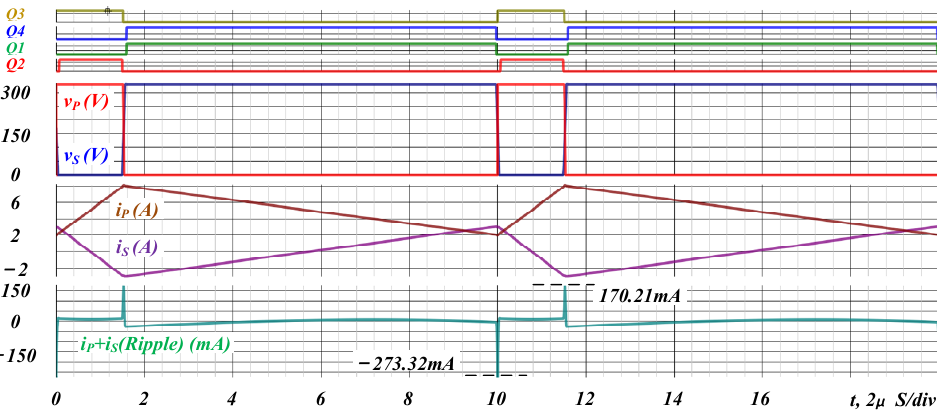
Figure 19. Simulation results of the output current ripple of a stacked buck converter with low output ripple dead time modulation.